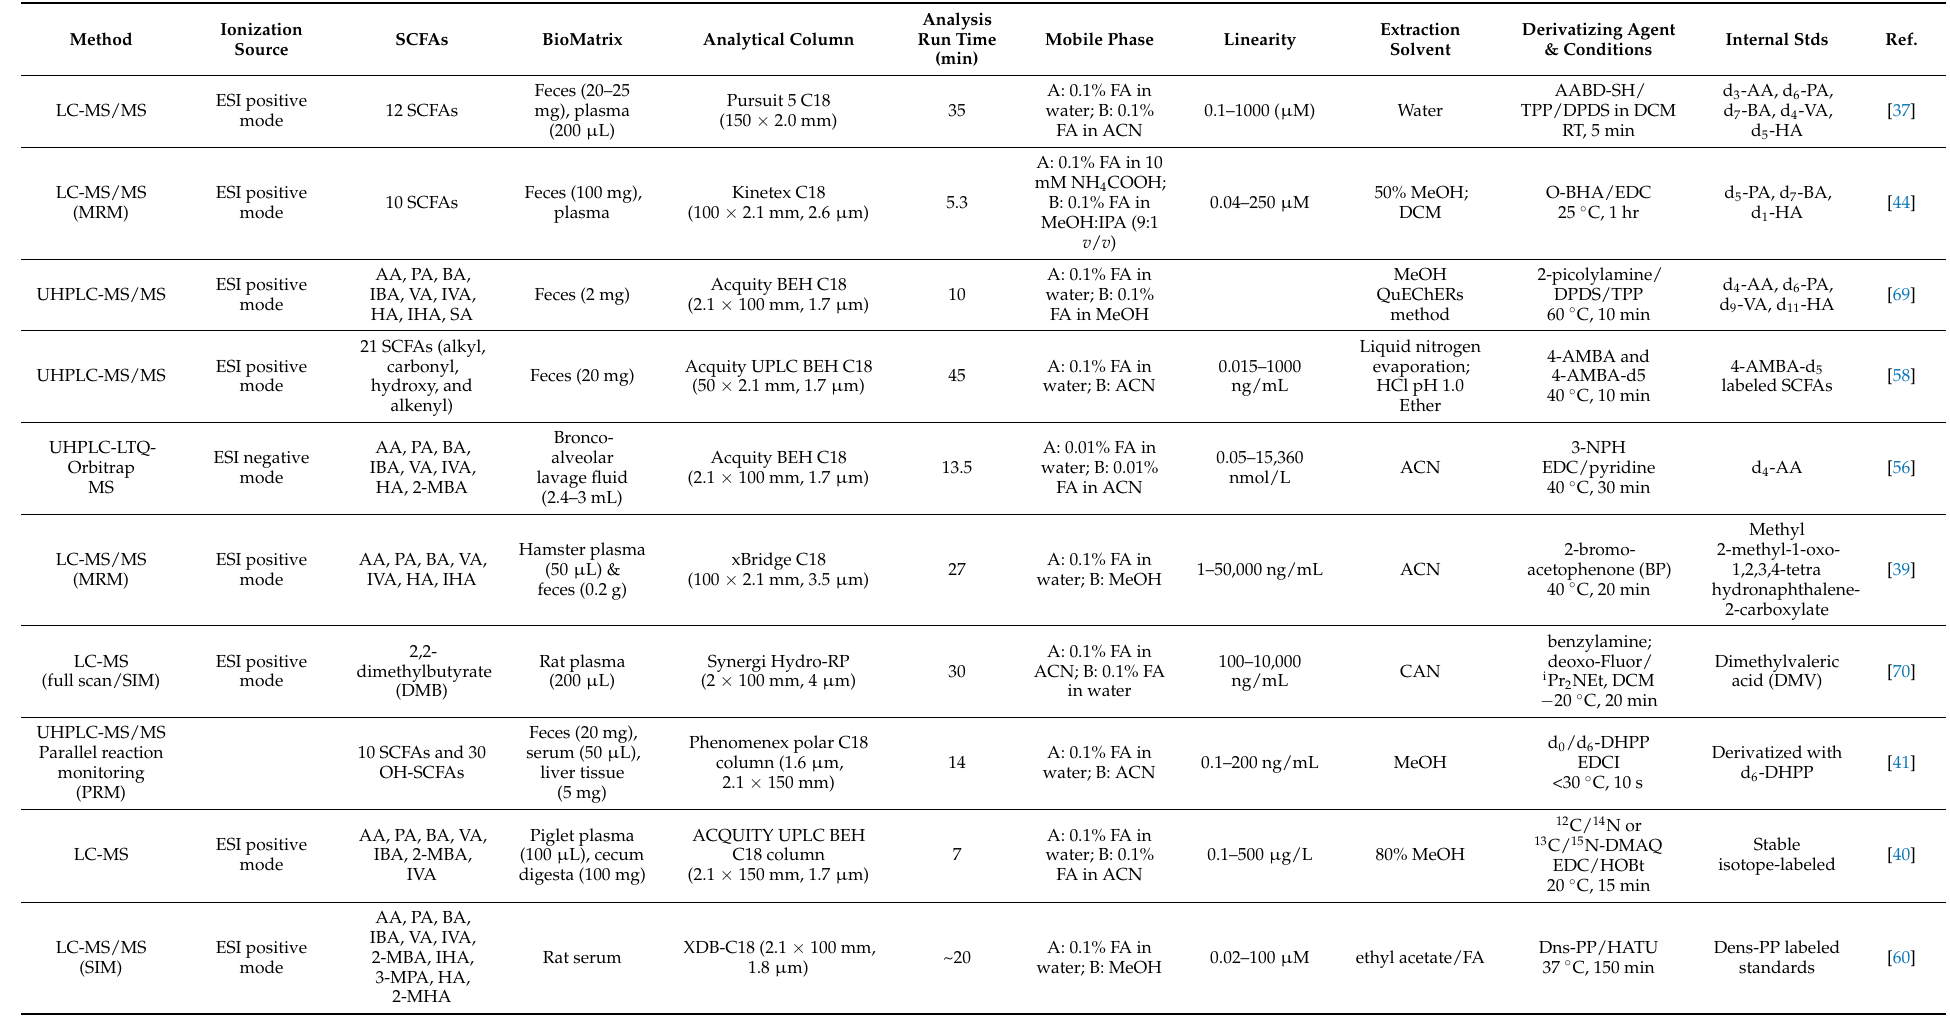
Table 3. SCFAs quantified in mouse/non-human blood, plasma, and